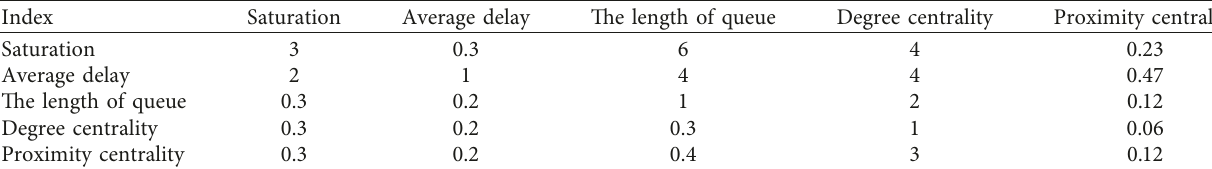
Table 1: Judgment matrix and the weight of each indicator.